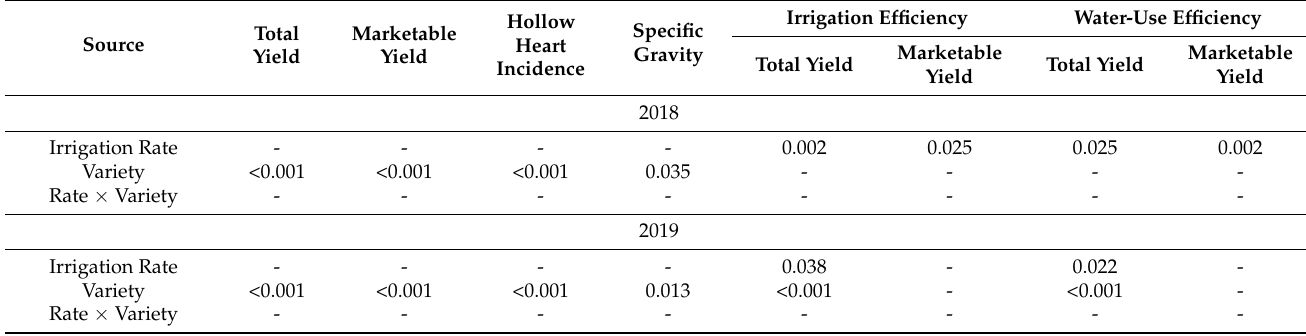
Table 2. At-harvest analysis of variance (ANOVA) results for 2018 and 2019.